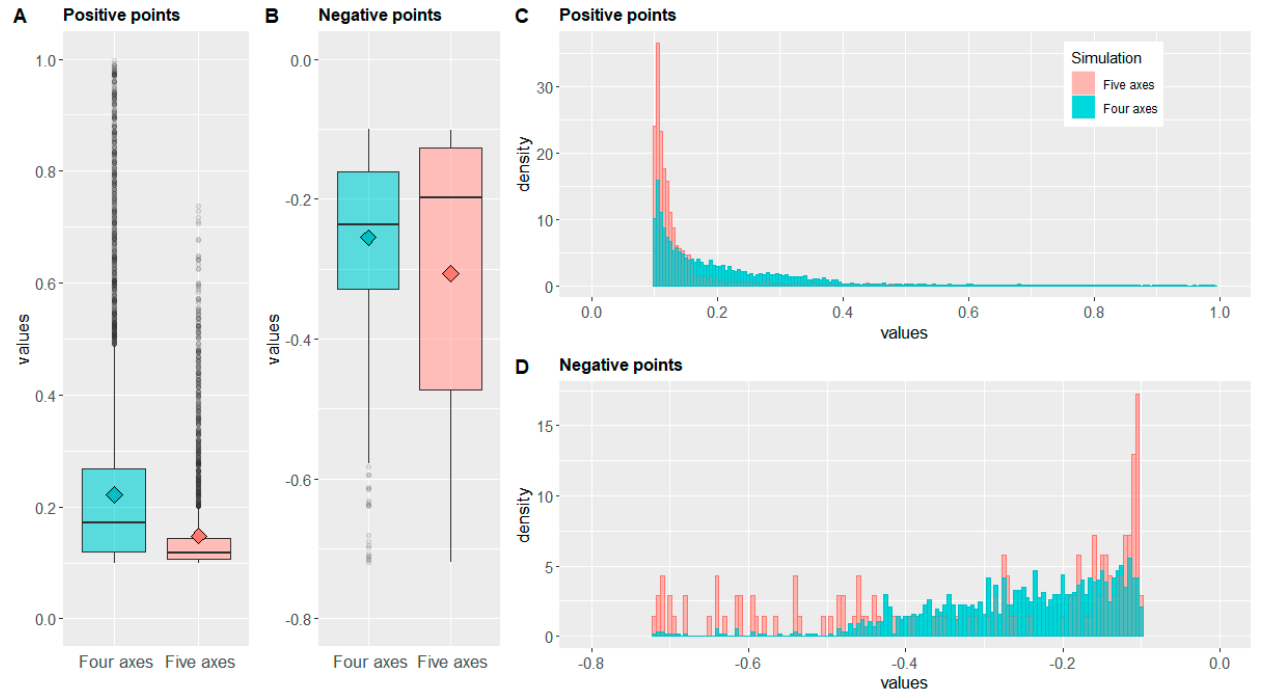
Figure 5. R plot of analysed data, green: the four axes CNC (computer numerical control) machine simulation and red: the five axes Robot simulation. ( A , B ) Boxplot comparison of the positive and negative values, respectively (lower line: values from the minimum to the first quartile, box: values from the first to the third quartile, horizontal line: median, square: mean, upper line: values from the third quartile to the maximum, and grey points: outliers). ( C , D ) Histogram comparison of positive and negative values respectively (bar width: 0.005).